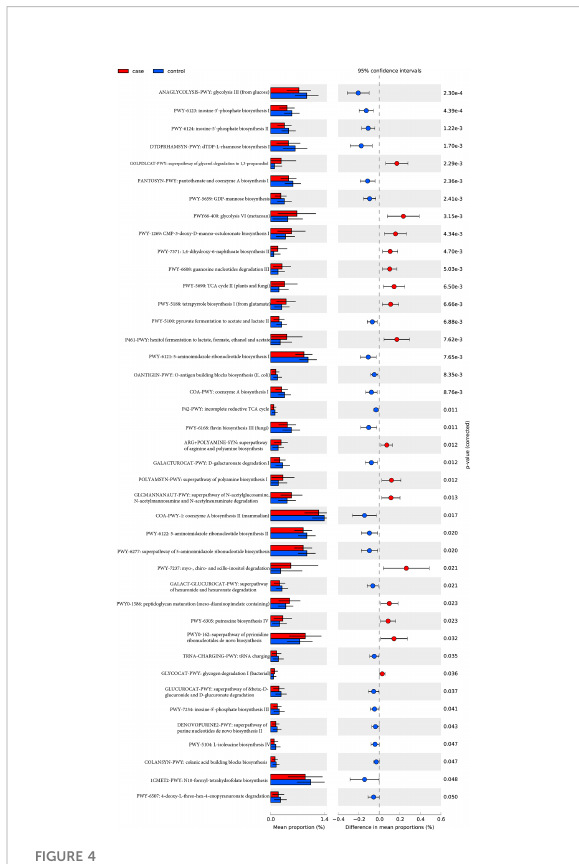
FIGURE 4 MetaCyc pathways with a signi fi cant difference in abundance between the case and control groups ( P -value corrected<